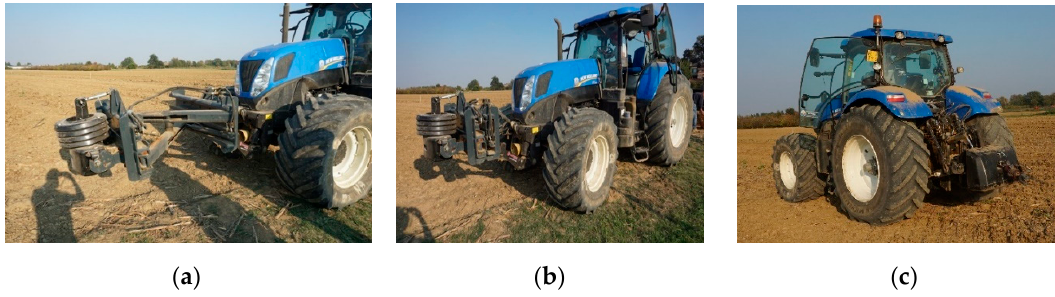
Figure 1. Multiplier Counterweight in ( a ) fully extended configuration (FE); ( b ) fully closed configuration (FC). ( c ) The test configuration R, where a standard 1000 kg ballast was mounted on the rear three-point hitch. Schematics for the calculation of tractor mass distribution are reported in Appendix A.